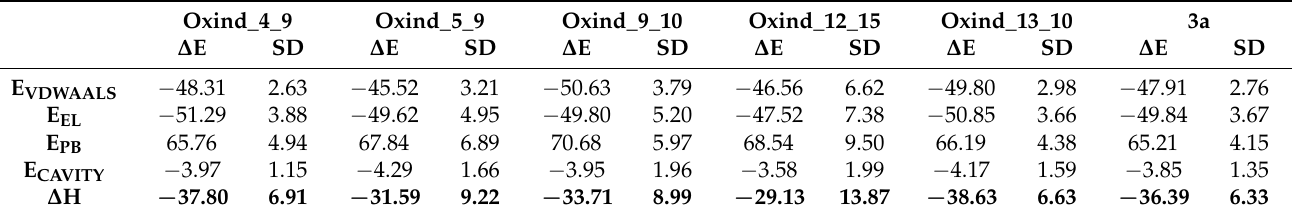
Table 5. The values of binding enthalpy ∆ H (kcal/mol) estimated for GSK-3 β complexes considered during the molecular dynamics stage (E VDWAALS = van der Waals contribution from MM; E EL = electrostatic energy; E PB = the electrostatic contribution to the solvation free energy calculated by PB; E CAVITY = nonpolar contribution to the solvation free energy; ∆ H = final estimated binding